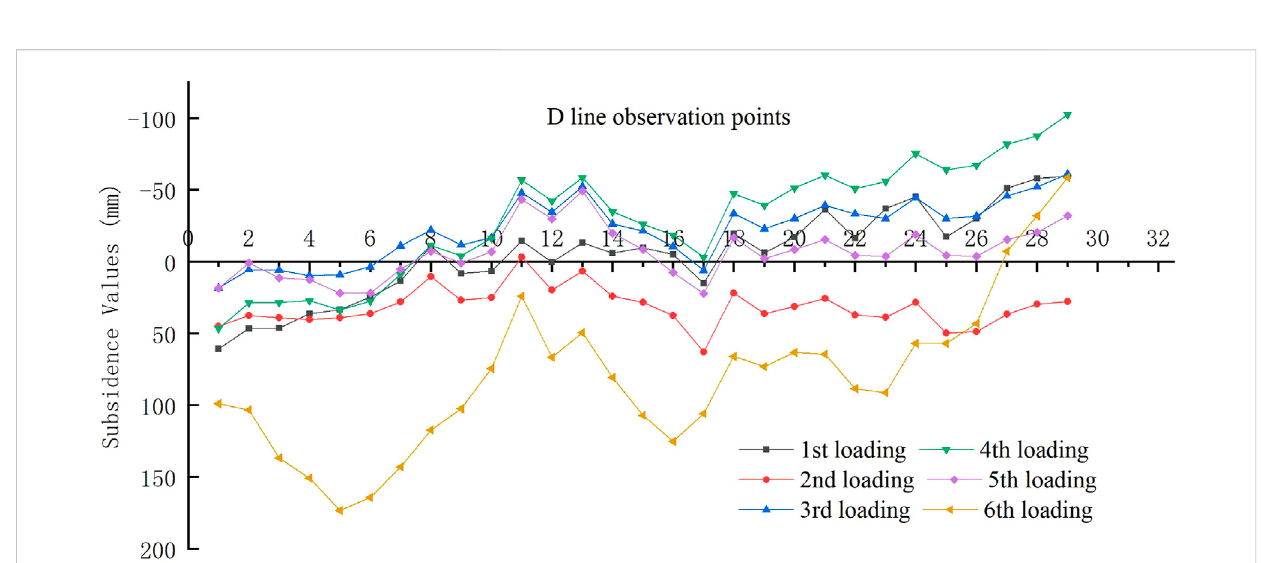
FIGURE 9 Curve of D line measuring point subsidence after